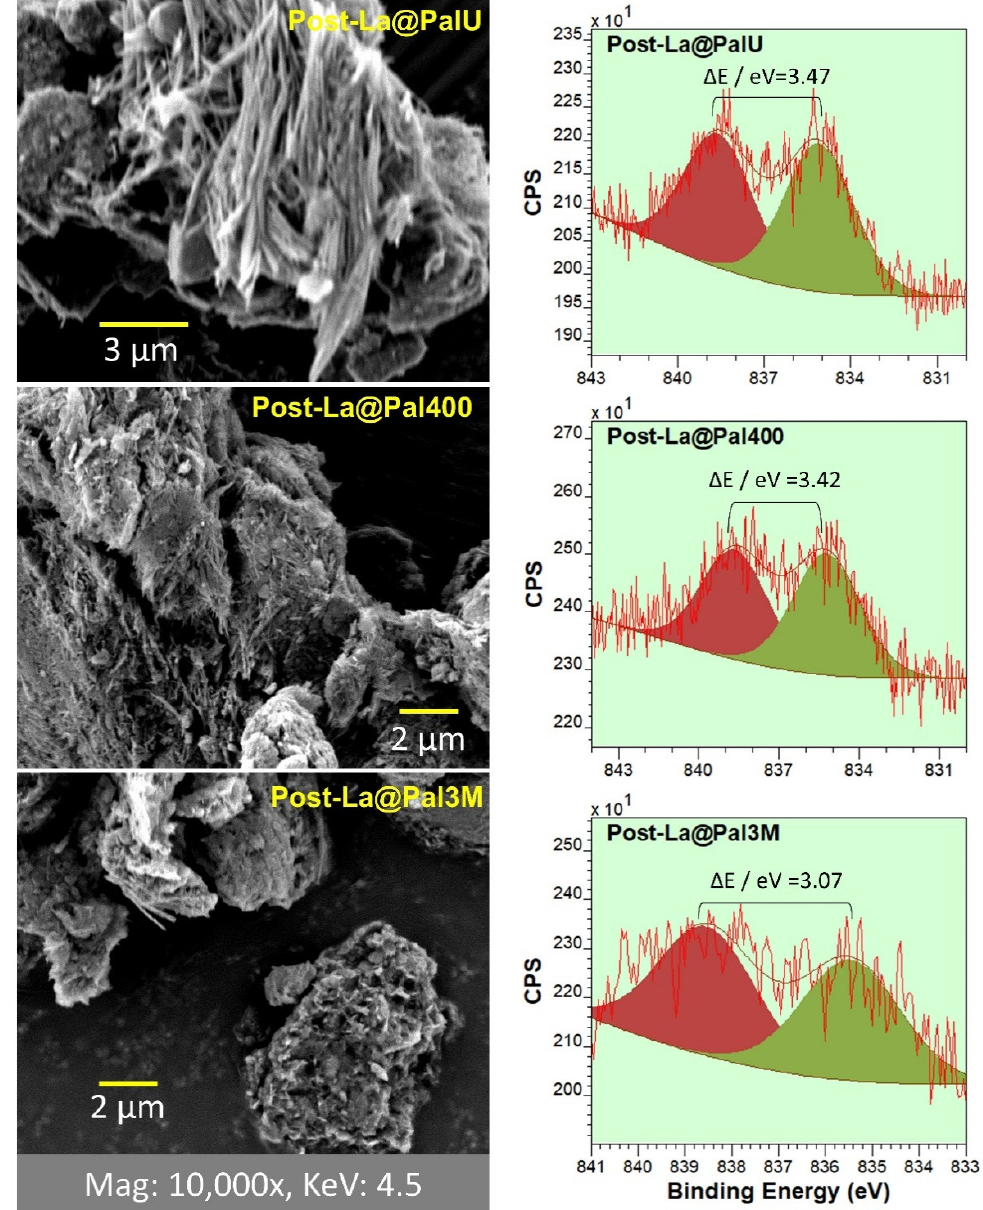
Figure 6. The SEM images of material after P adsorption in MQ water (left column) and the high- resolution XPS of La region of selective spent material of La-modified